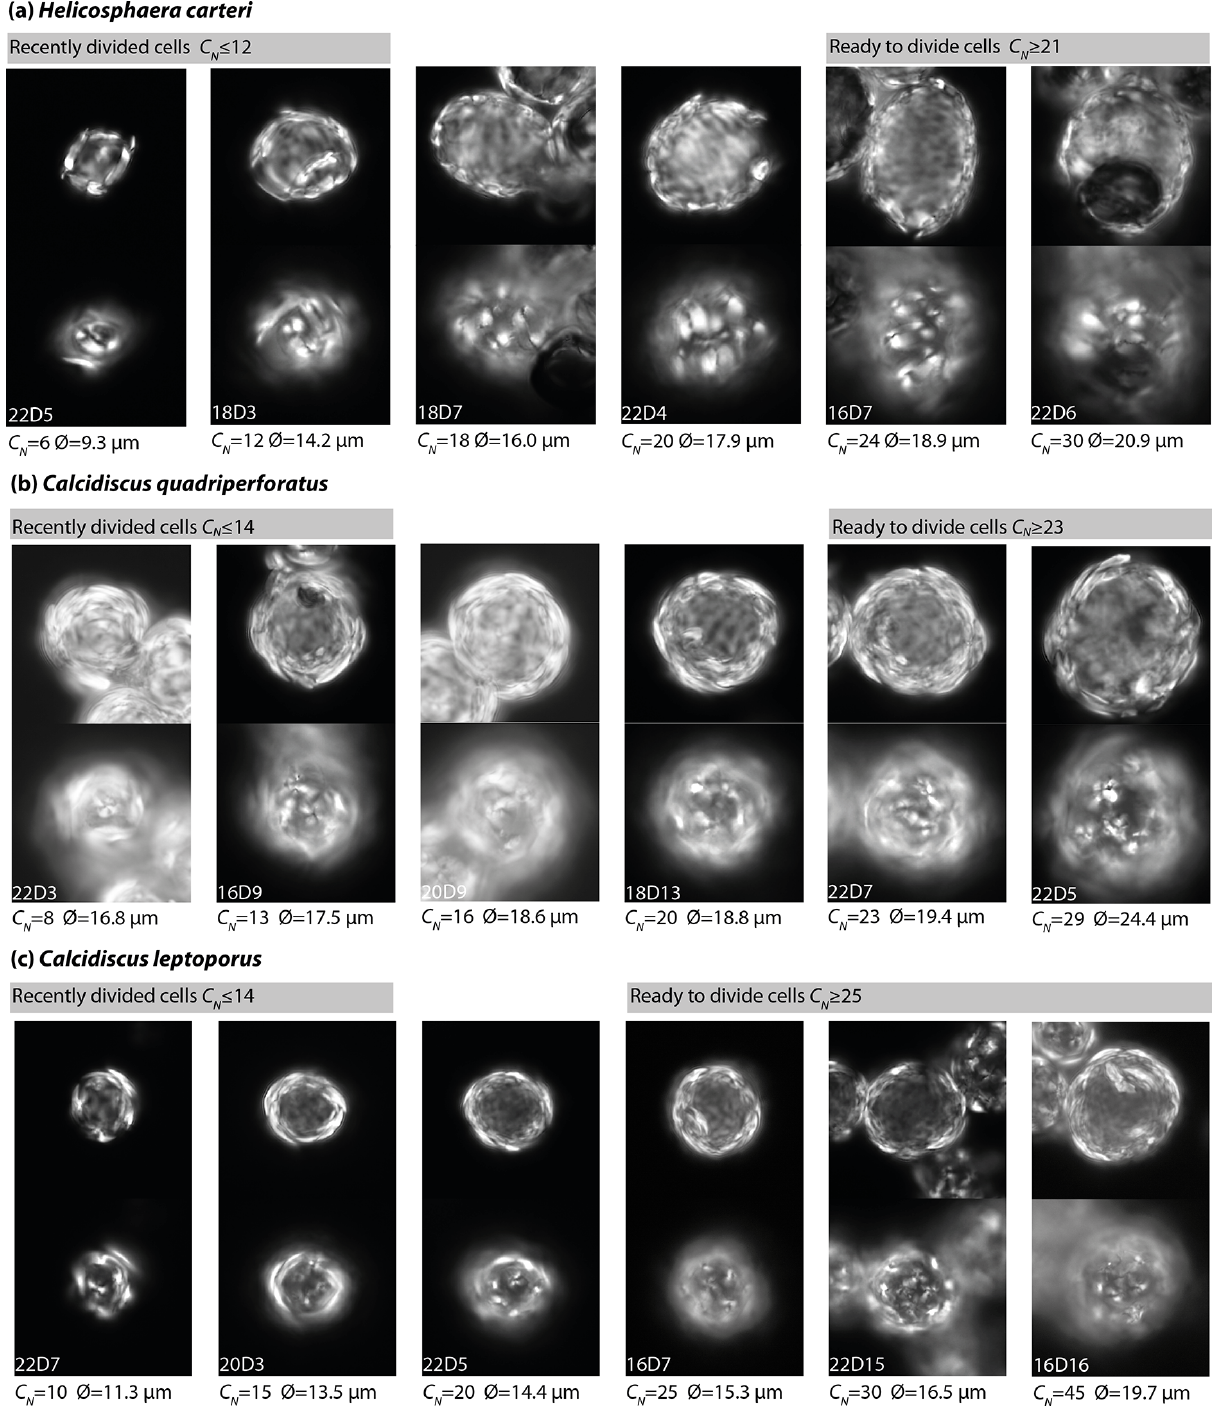
Figure 4. Light microscopy images illustrating the full range of cell geometry observed across all experiment days within cultures of (a) H. carteri , (b) C. quadriperforatus and (c) C. leptoporus at 16–22 ◦ C. The upper image of each pair shows the cross-sectional view of the cell, from which coccosphere diameter and cell diameter are measured. The lower image of each pair shows a coccolith-focused view of the cell, from which coccolith length is measured. Number of coccoliths per cell ( C N ) and coccosphere diameter ( ∅ ) are given for each cell. End-member geometries illustrating recently divided and ready-to-divide cells are shown, based on their C N and ∅ . Both exponential-phase and non-exponential-phase cultures will contain some recently divided and some ready-to-divide cells, but the proportion (%) of each will differ depending on growth phase, as shown in Figs. 3 and 6. A reference code for the experiment day that the image was taken from is also given. For example, 22D7 would be a cell from day 7 of the 22 ◦ C experiment. All images are to the same